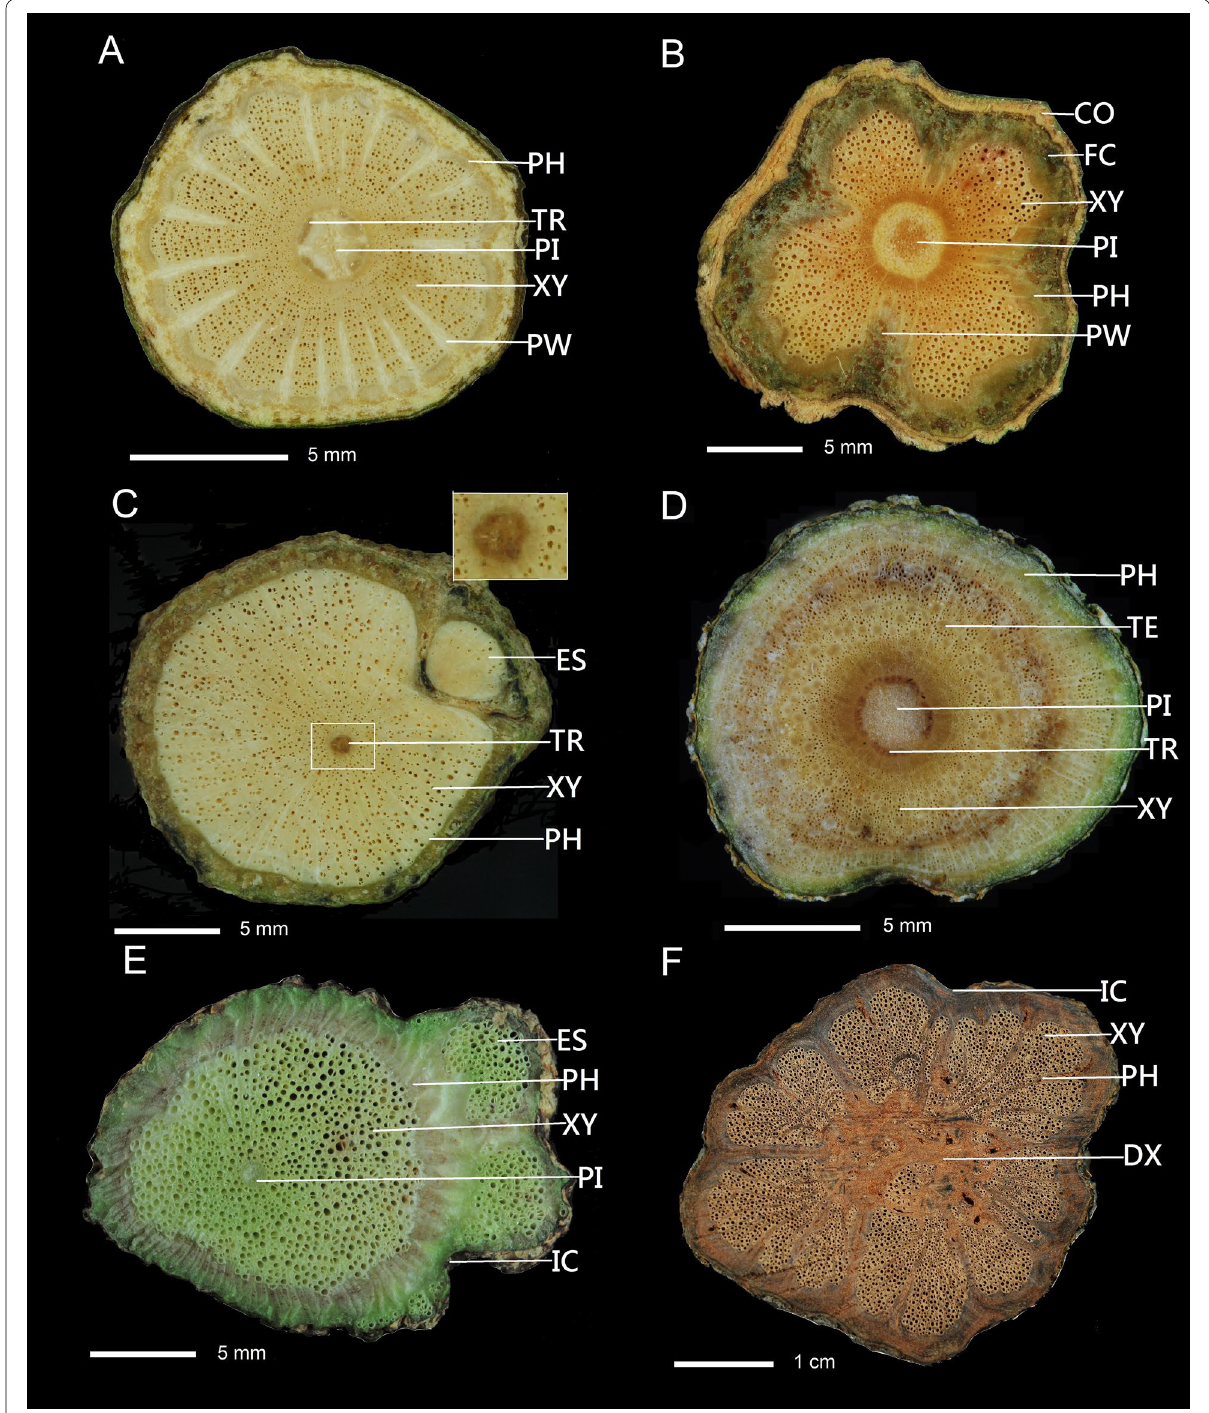
Fig. 3 Combination of two cambial variants of stem cross section. A Furrowed xylem of cambium discontinuity combined with intraxylary phloem: Gardneria multiflora . B Furrowed xylem of cambium continuity combined with irregular conformation; Coptosapelta diffusa. C External secondary vascular cylinders combined with intraxylary phloem: Trachelospermum gracilipes. D Interxylary phloem combined with intraxylary phloem: Strychnos cathayensis . E External secondary vascular cylinders combined with irregular conformation: Lablab purpureus. F Fissured stem/dispersed xylem combined with irregular conformation: Bauhinia championii . PI, pith, FC, furrowed xylem of cambium continuity, PW, phloem wedges, IC, irregular conformation, PA, parenchyma, DX, fissured stem/ dispersed xylem, TR, intraxylary phloem, ES, external secondary vascular cylinders, XY, xylem, PH, phloem, TE, interxylary